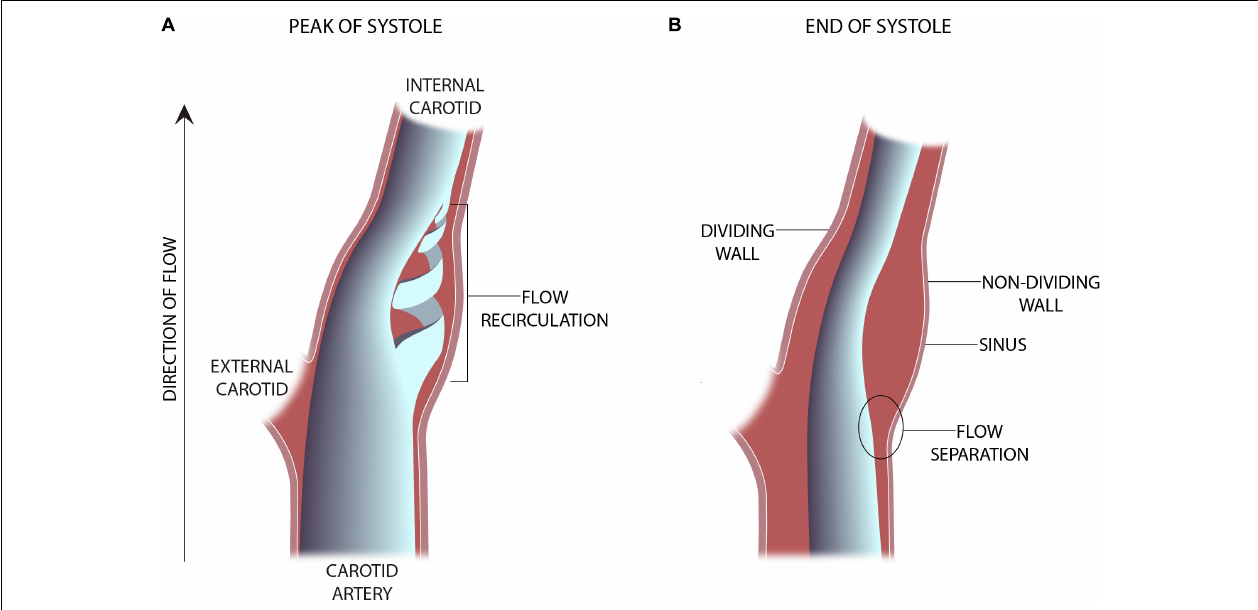
FIGURE 1 | Schematic representation of an in-vitro experimental model of the carotid sinus (Ku and Giddens, 1983). (A) The presence of vortical or flow recirculation during the peak of systole results in sheer stress “impulses” against the sinus wall. (B) The anatomy of the sinus causes flow separation from the non-dividing wall resulting in a region of low wall shear